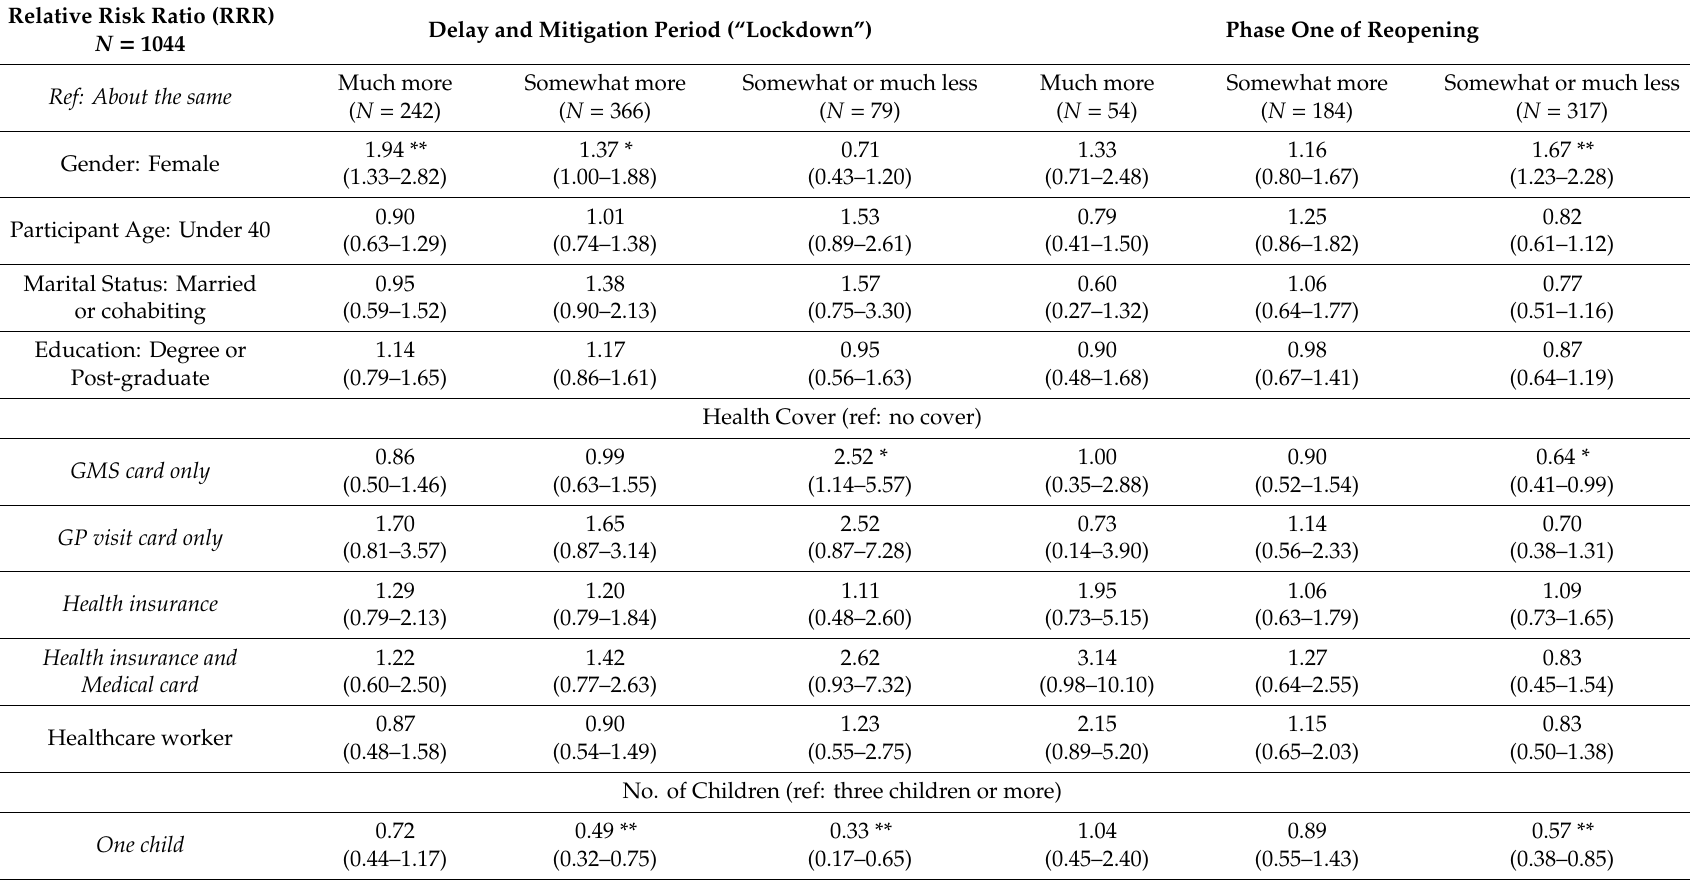
Table 2. Multinomial regression